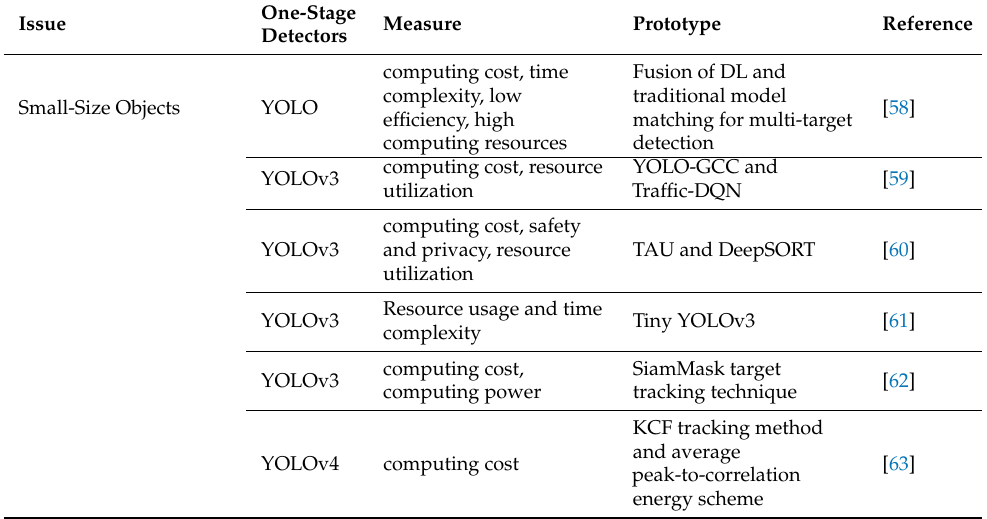
Table 2. One-stage detectors to tackle the issues in target